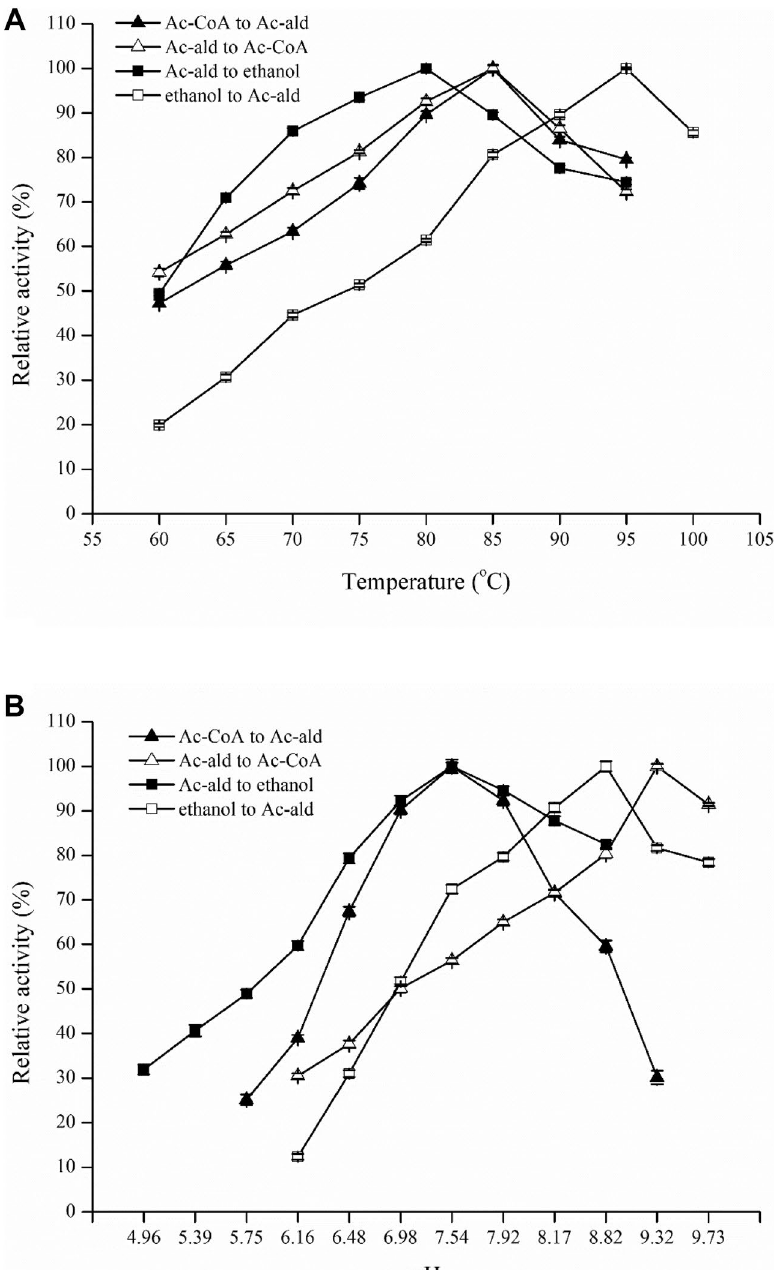
reaction mixture described in Materials and Methods. ( B ) The effects of pH on the activities of Fe-AAdh. The buffer composition for these assays was 25 mM each of phthalate, MOPS, Tris, and glycine with pH values calibrated at 80 °C, and the other conditions were the same as those for the standard assays. The highest activity was set as